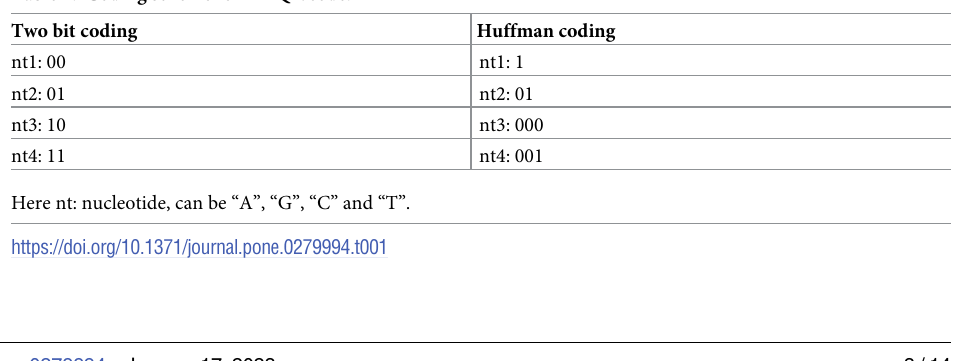
Table 1. The second scheme was the Huffman coding [12]. We then used the following coding table, ’1’- > nt1, ’01’- > nt2, ’001’- > nt3 and ’000’- > nt4. The coding method can be seen in Table 1.